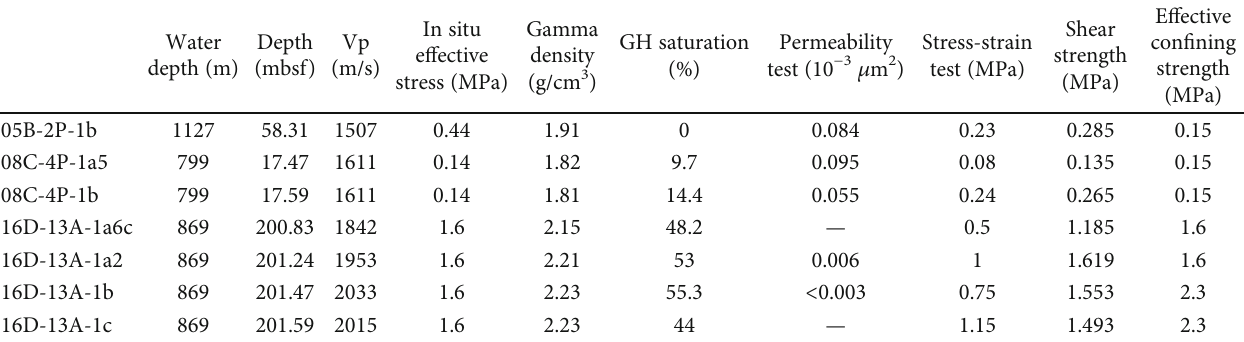
Figure 1: Topography of the study area and the location of the drilling sites. The inset shows the topography of the South China Sea and the location of the study area. Table 1: Information about the subsamples and test